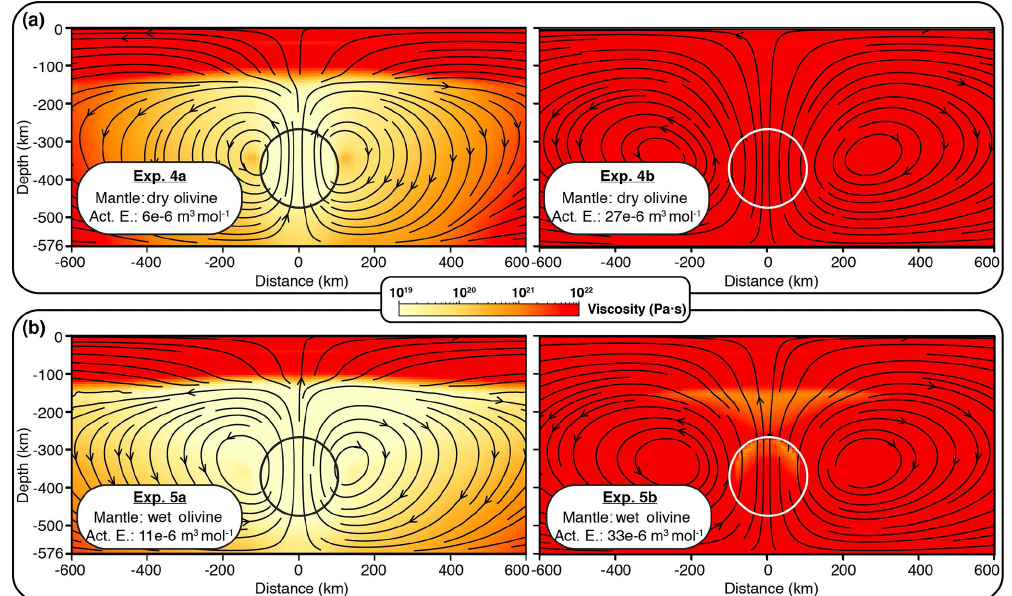
Figure 5. Viscosity map and streamlines for experiments using nonlinear rheologies (dry or wet olivine) with various activation energies. The rising sphere is shown by the